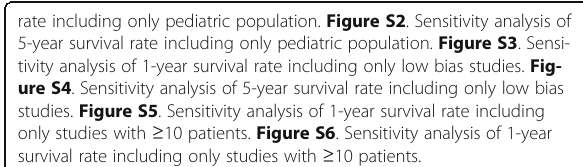
studies. Figure S5 . Sensitivity analysis of 1-year survival rate including only studies with ≥ 10 patients. Figure S6 . Sensitivity analysis of 1-year survival rate including only studies with ≥ 10